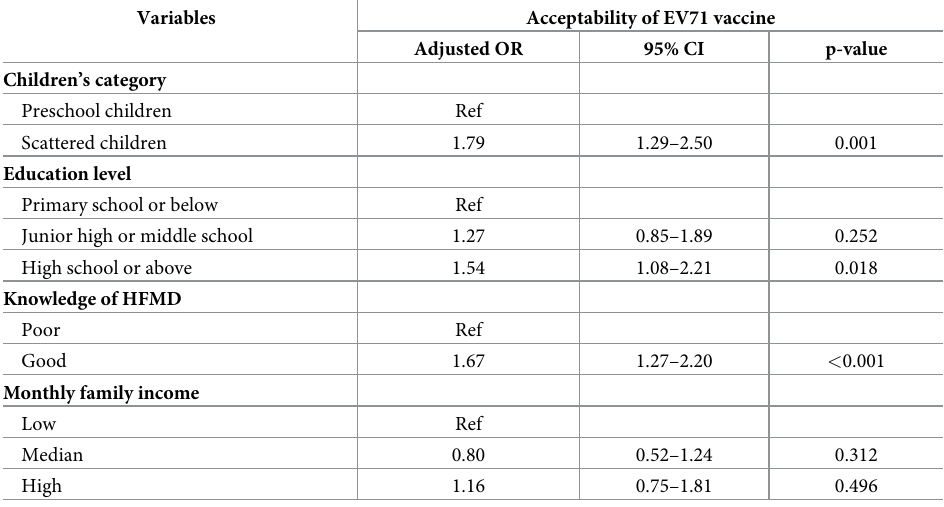
Table 5. Factors potentially influencing the acceptability of EV71 vaccine among participants in study of knowl- edge of HFMD and acceptability of EV71 vaccine among parents of under-five in Chongqing,